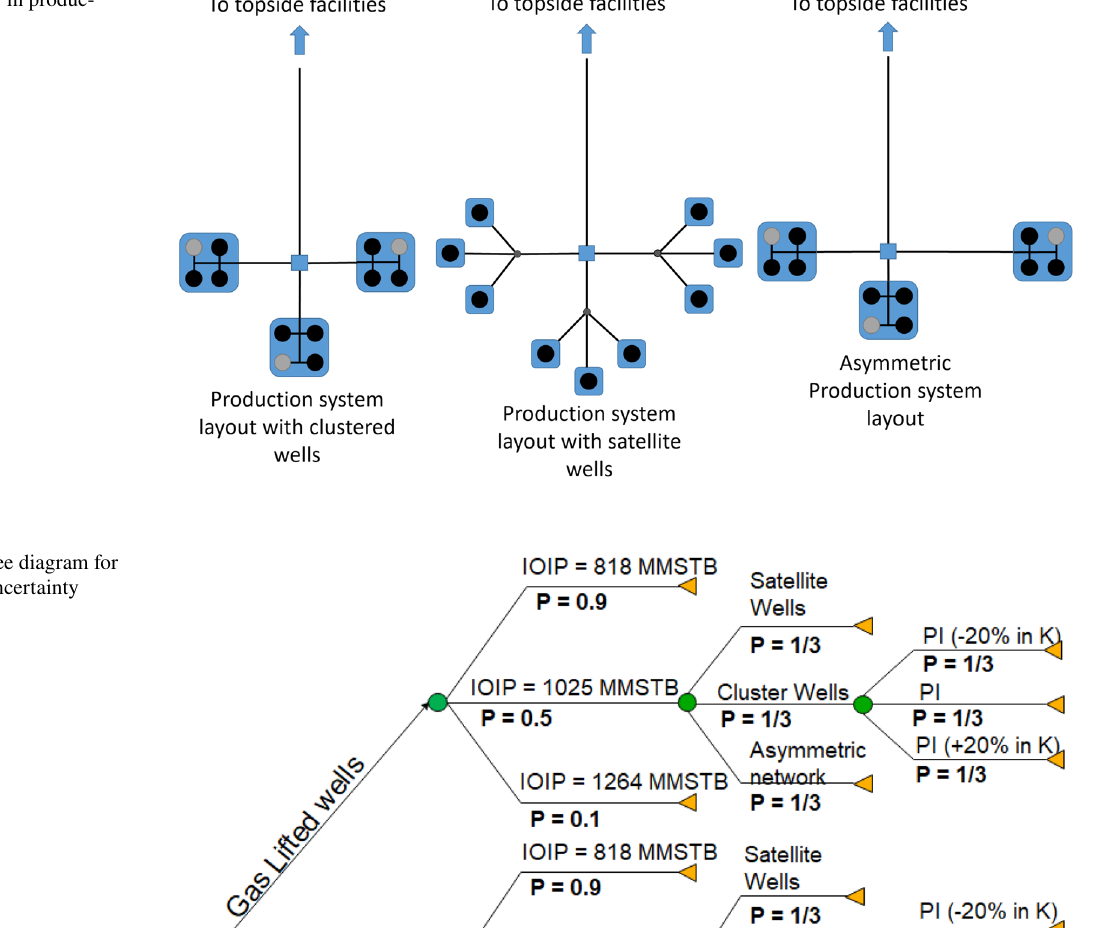
Fig. 7 Uncertainty in produc- tion system layout